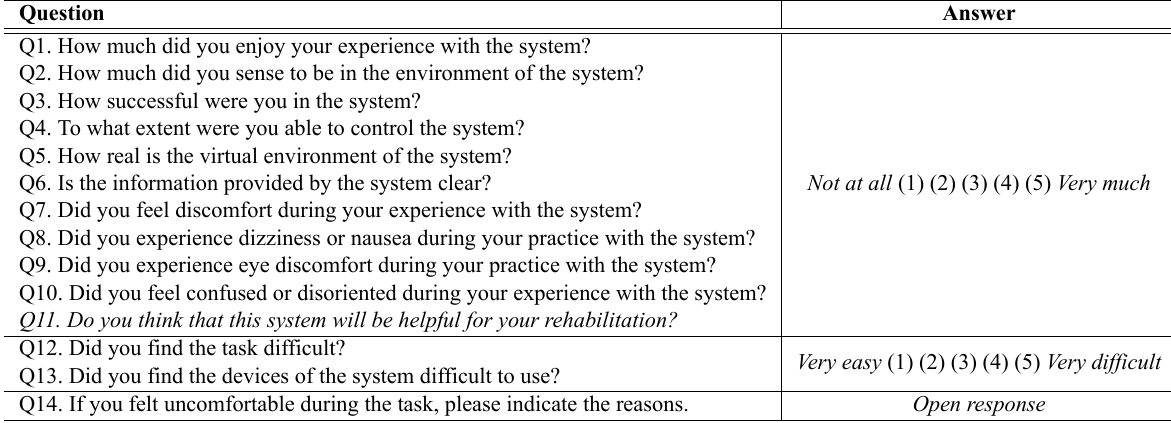
Table 3. Original Suitability Evaluation Questionnaire from Gil­Gomez et al. (2013).